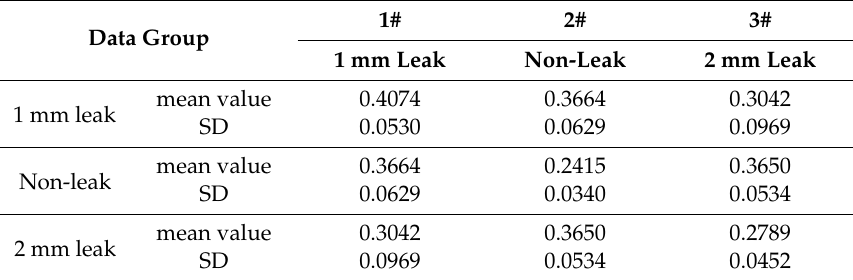
Table 3. Mean values and SD of ambiguity correlation coefficients using VMD method.